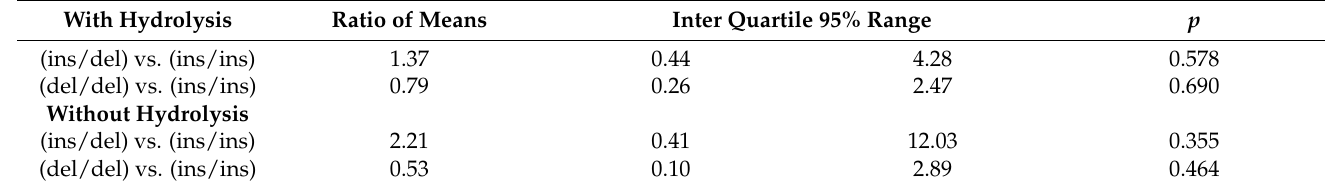
Table 2. Androgenic responses in urine, analyzed by AR CALUX ® with and without hydrolysis presented as values of the ratio of means. For the interpretation of the ratios of means, the homozygous polymorphism wild type (ins/ins) group has been taken as the reference compared to the other two groups, heterozygous (ins/del) and homozygous mutated (del/del). For the comparison, the ratio of means, the inter quartile range, and the p value are presented. With Hydrolysis Ratio of Means Inter Quartile 95% Range p